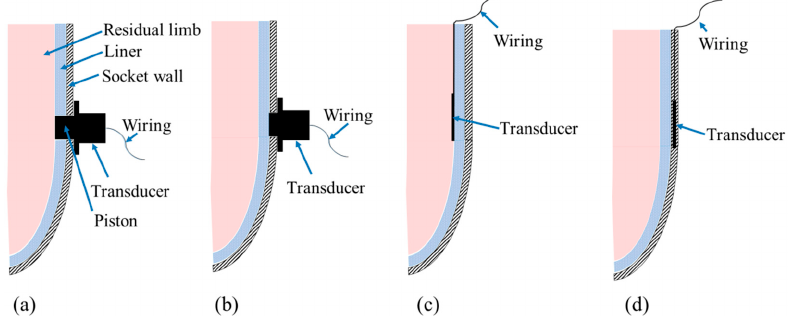
Figure 1. Transducer mounting techniques: ( a ) transducer mounted on socket wall through drilled hole and the piston extended to be in direct contact with residual limb skin; ( b ) the same mounting technique with a slight difference that the piston is flush with the inner socket face and does not penetrate the liner; ( c ) transducer inserted inside prosthetic socket; and ( d ) transducer embedded in the socket wall.